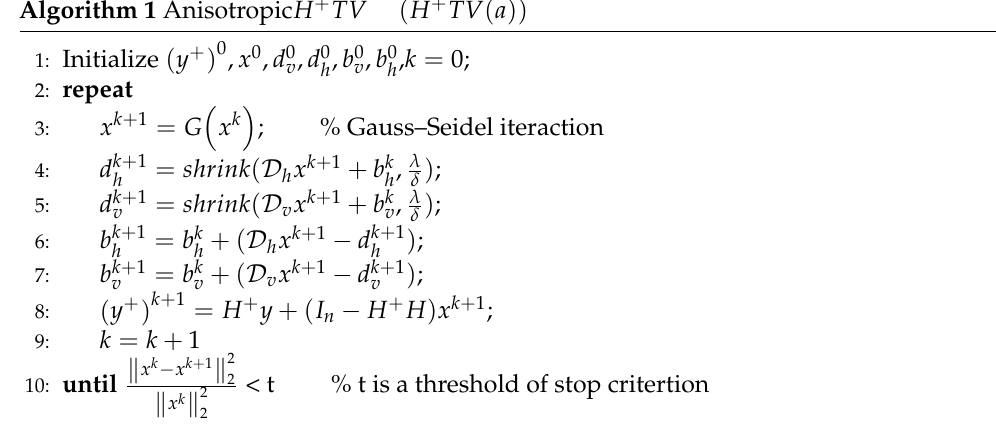
Algorithm 1 Anisotropic H + TV